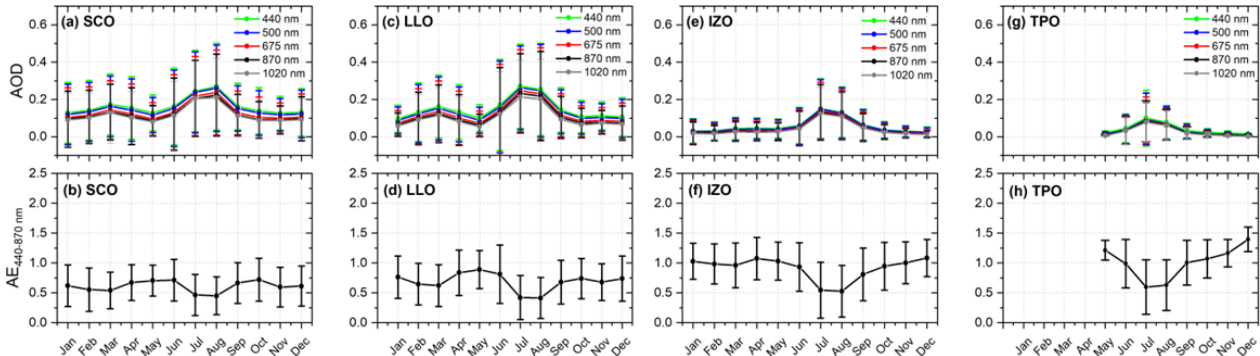
Figure 2. Monthly mean aerosol optical depth (AOD) at 440, 500, 675, 870 and 1020nm and Ångström exponent (AE 440 − 870nm ) at SCO